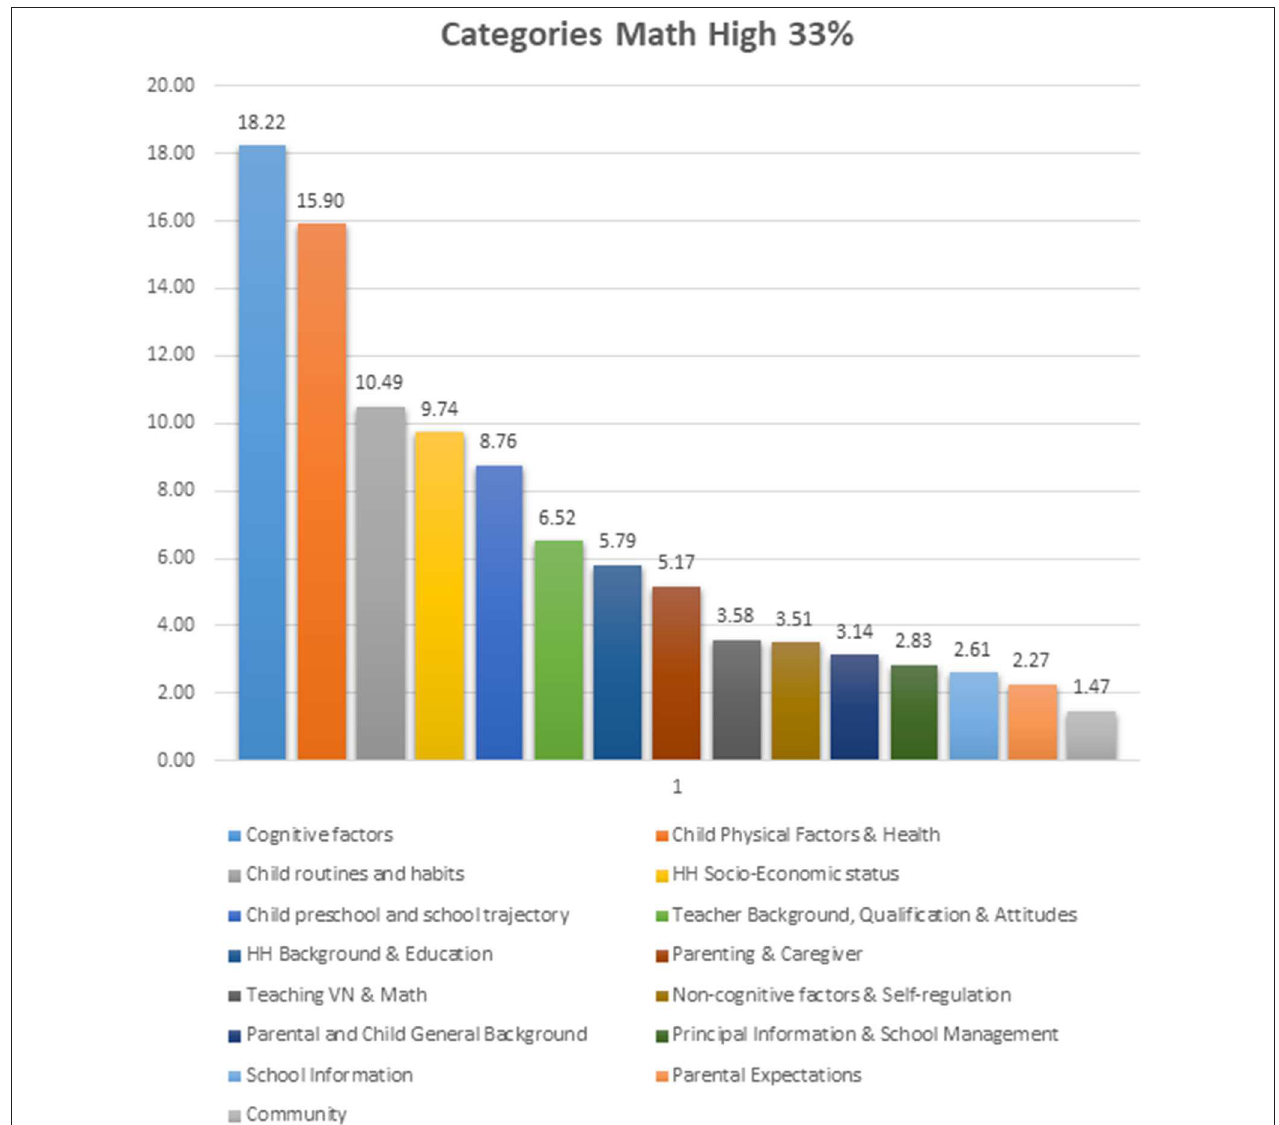
FIGURE 1 | Comparative observed predictive weight contribution for the high 33% of math performance by each of the categories of predictor variables.